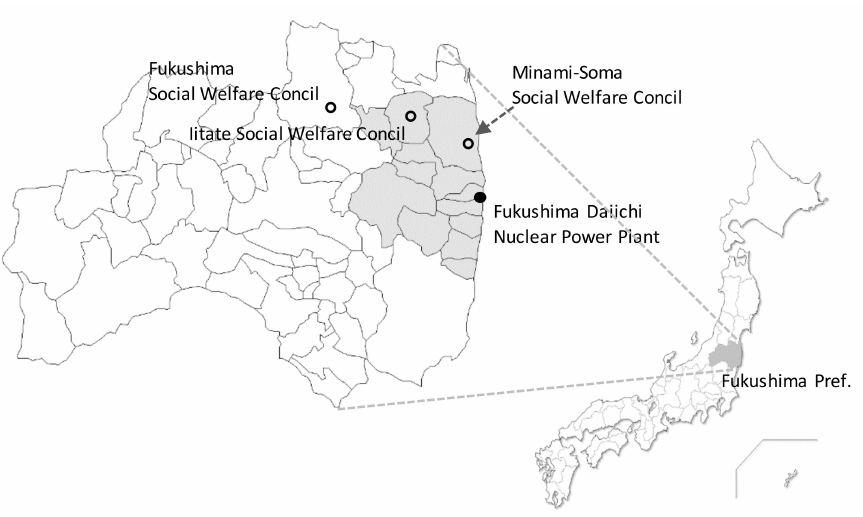
Figure 1. Locations of the Iitate, Minami-Soma, and Fukushima Social Welfare Council and Evacuation areasoftheFukushimaDaiichiPowerPlantaccident: TheSocialWelfareCouncilsofIitate, Minami-Soma, and Fukushima are identified by white circles. The location of the Fukushima Daiichi Nuclear Power Plant shown by a black circle. Regions colored in dark gray correspond to municipalities where evacuation orders were